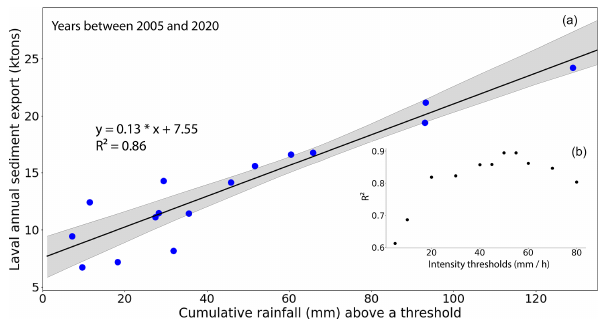
Figure 6. (a) Linear correlation between annual total sediment ex- port from the Laval catchment and the cumulative rainfall above an instantaneous intensity threshold of 50mmh − 1 for the years 2005 to 2020 (blue dots). The regression line is in black; grey shaded area shows the 95% confidence interval. Most outliers occur for low cu- mulative rainfall above the threshold ( < 40mm). (b) The coefficient of determination ( R 2 ) between annual sediment export and annual rainfall above the threshold for different intensity thresholds. Op- timum correlations are found for threshold values between 50 and 55mmh − 1